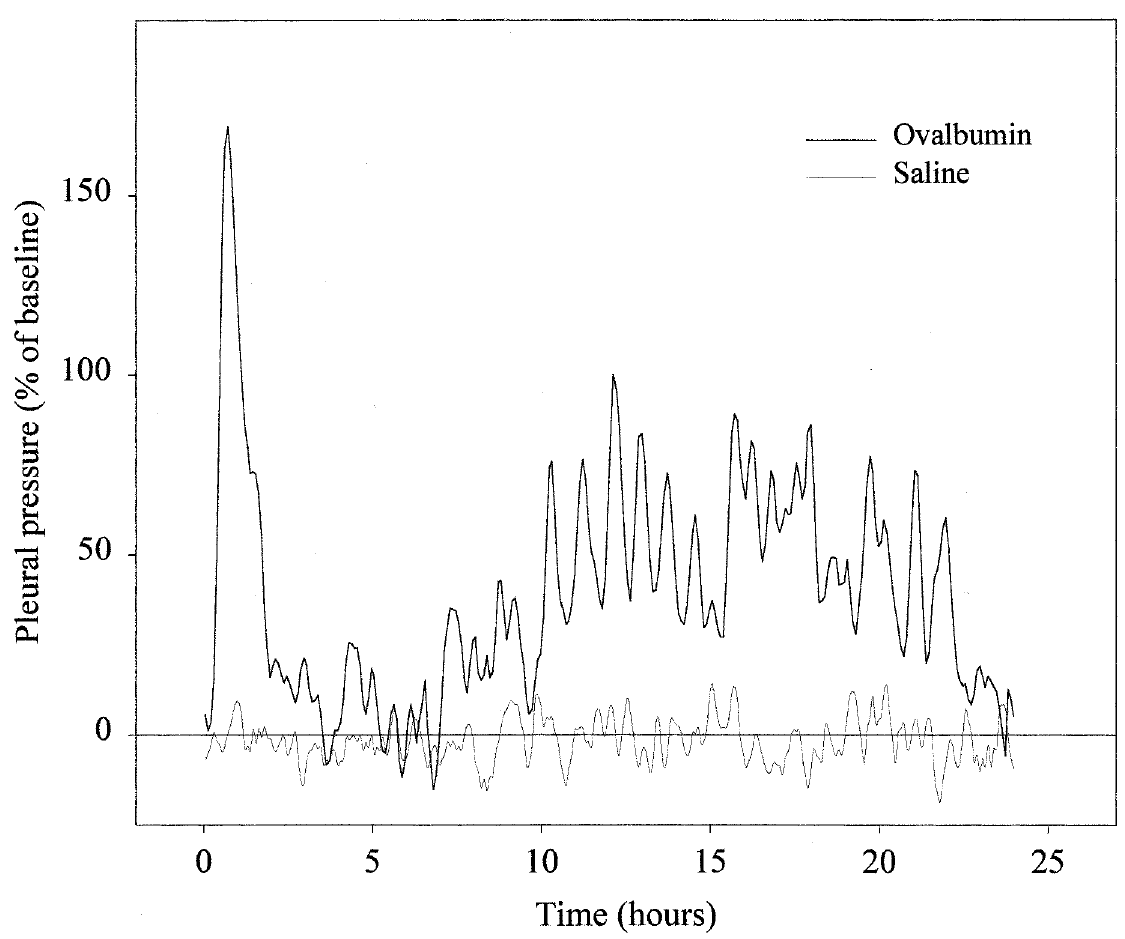
FIG. 2. Representative example of a dual asthmatic response after allergen provocation of an ovalbumin-sensitized guinea pig (thick line). The thin line represents the result of a saline control challenge. Provocations were performed at 0h.